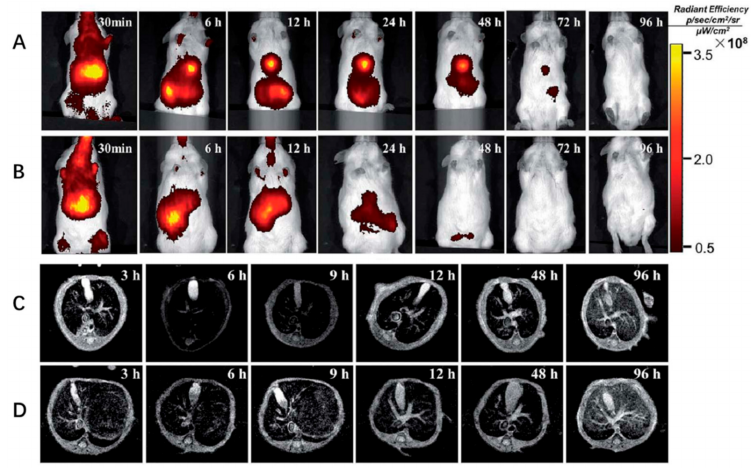
Figure 2. In vivo optical imaging and MRI of liver fibrosis using SPIO@SiO 2 –ICG–RGD. ( A , C ) A model of hepatic fibrosis in mice. ( B , D ) Healthy mouse model (control). Adapted with permission from